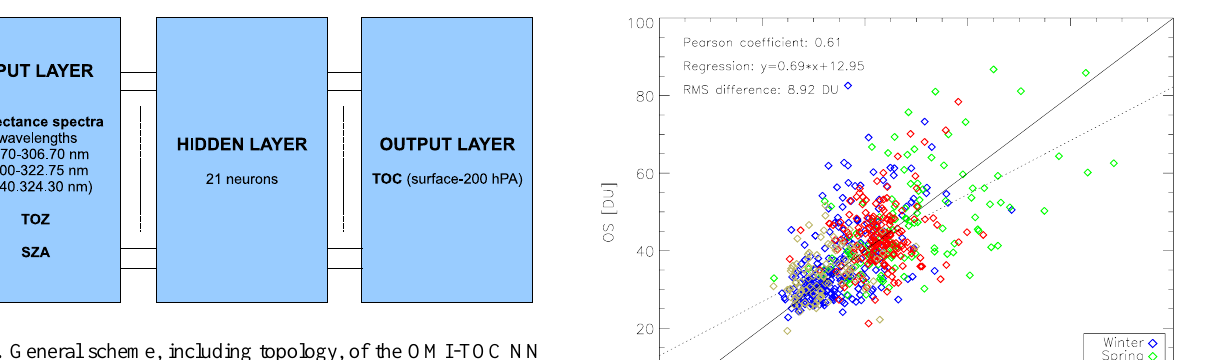
Fig. 3. Scatter plot of OMI-TOC NN retrievals versus correspond- ing OS TOCs for the test data set. Seasons are plotted in different colors (see legend).